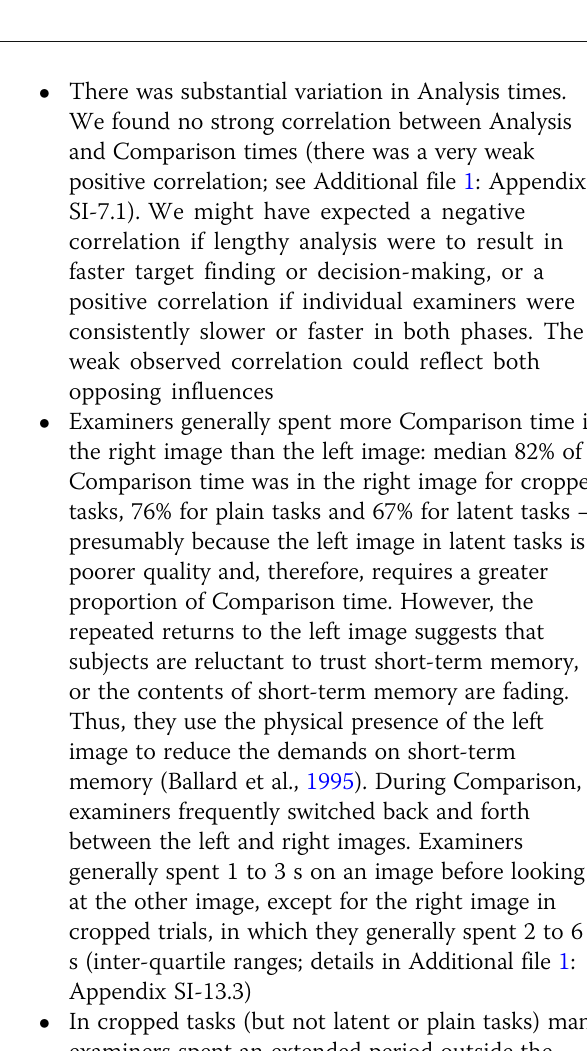
“ timeline ” view. Figure 9 (and the timelines for other